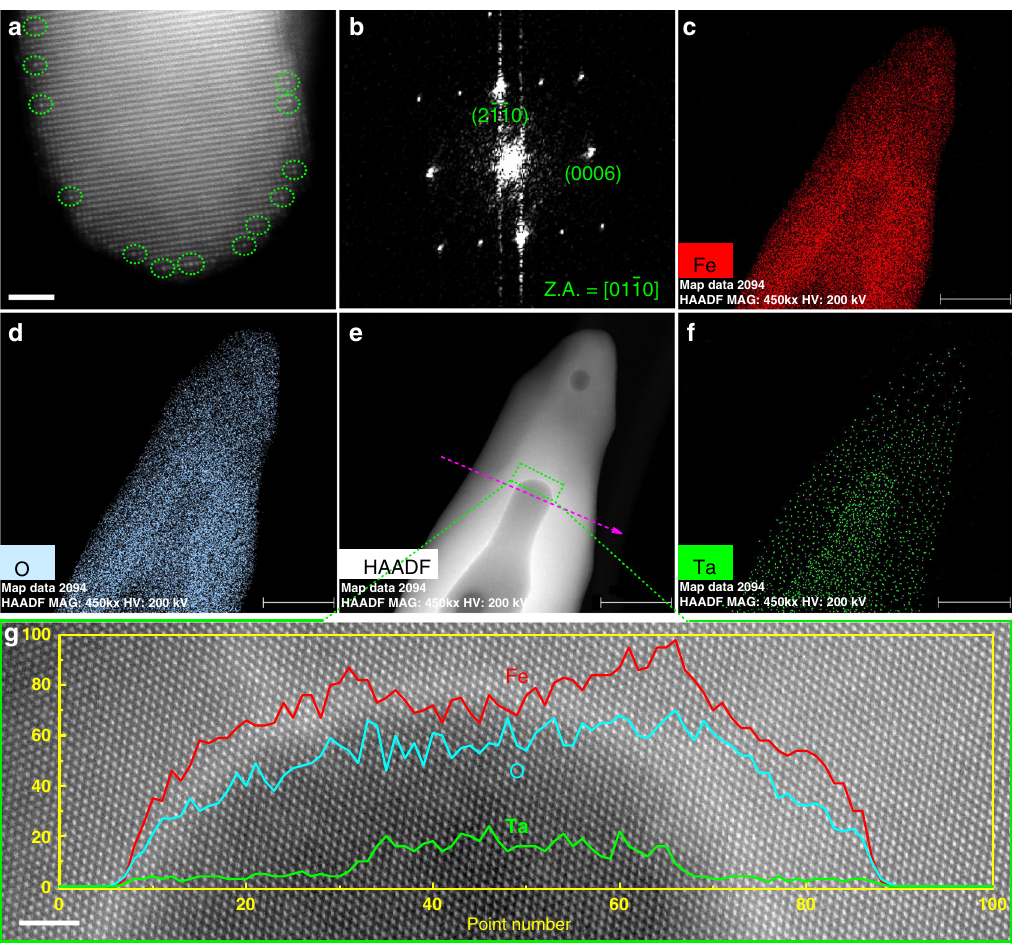
Fig. 2 HAADF-STEM of Ta:Fe 2 O 3 and Ta:Fe 2 O 3 @Fe 2 O 3 homojunction. a HRSTEM image of Ta:Fe 2 O 3 nanorods (circles are Ta atoms). b SAED of Ta: Fe 2 O 3 . c – f EELS mapping for a Ta:Fe 2 O 3 @Fe 2 O 3 homojunction nanorod. g HRSTEM of homojunction nanorod (inset is the corresponding EELS linear scanning along the dashed arrow in e . The scale bar is 40 nm in c – f and 2 nm in a and g